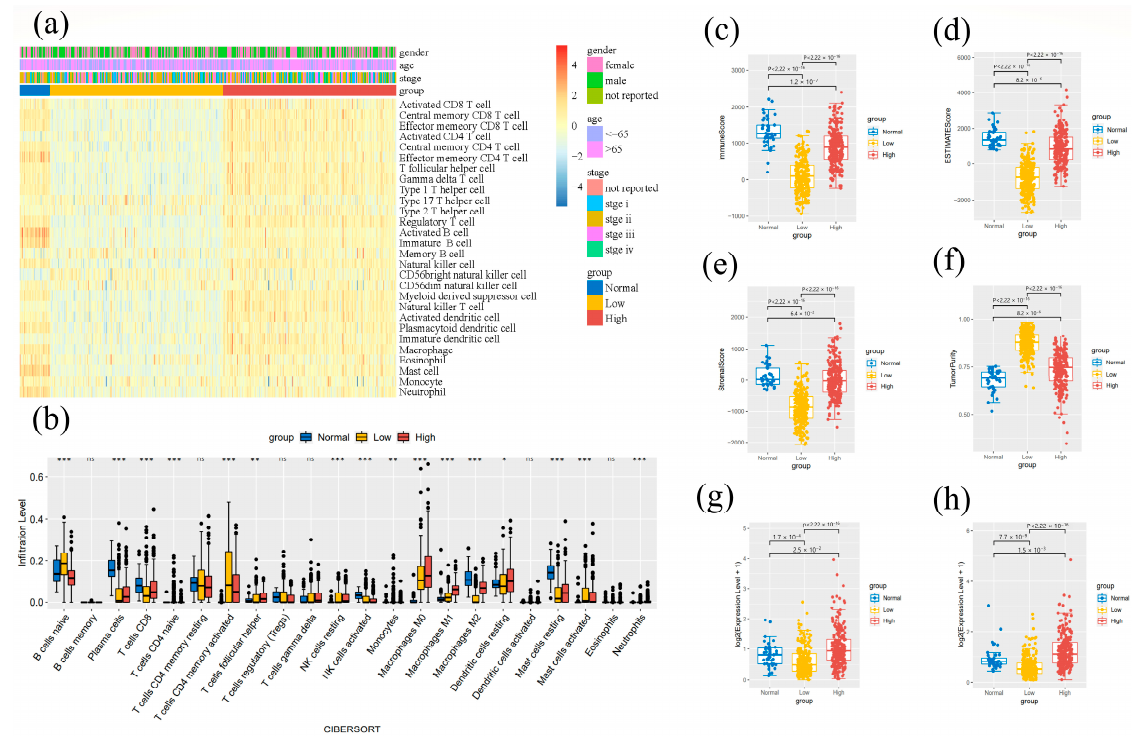
Figure 5. Evaluation of CD163 expression related to TME based on colorectal cancer cases in